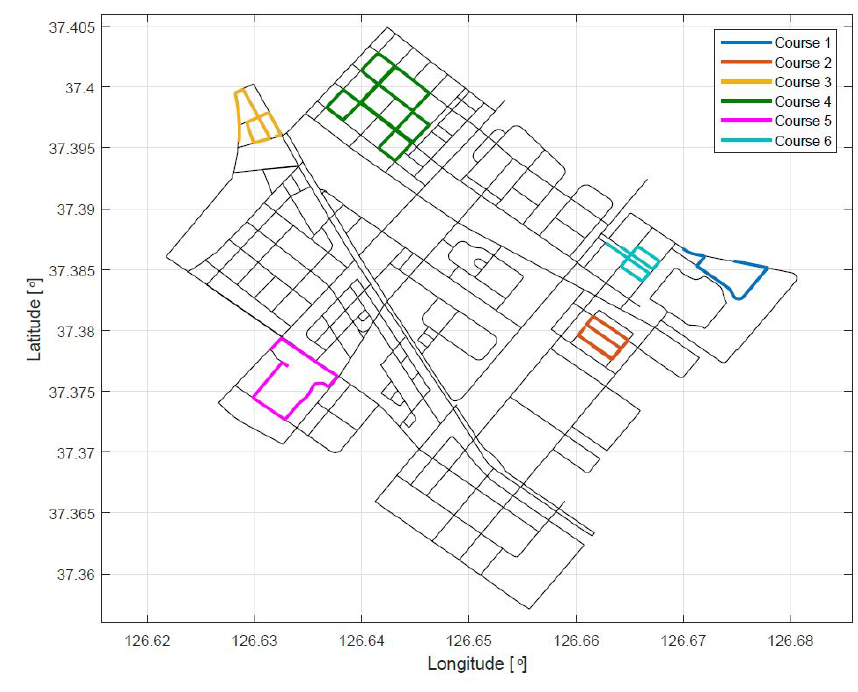
Figure 7. Overall map comprising six courses. Table 1. Length and number of GPS points of the experimental